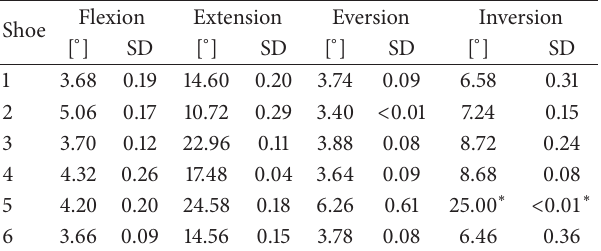
Table2:Meanankleanglesandstandarddeviations(SD)fromall24 measurements sorted by anatomical movements ( ∗ device reached